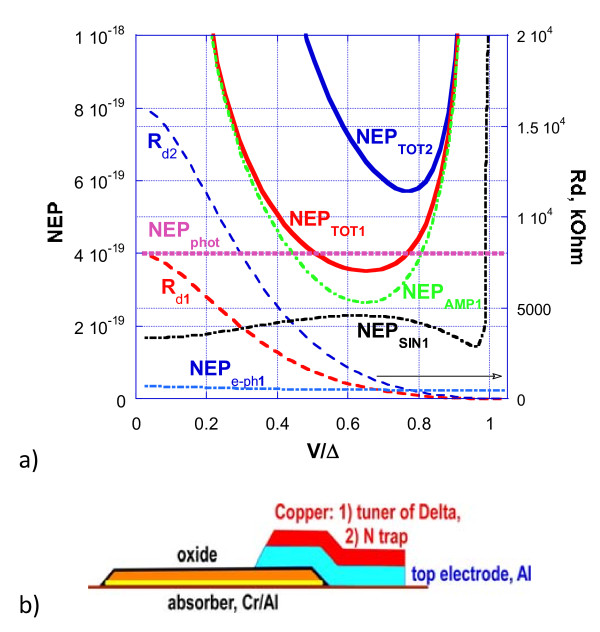
 NEP components for the 2D array of CEBs with a single SIN junction and a SN Andreev contact (marked by “1”) and with a double SIN junction (marked by “2”). The array consists of four CEBs in parallel (W = 4) and eight CEBs in series (N = 8). Dynamic resistance, Rd, is shown for both cases, on the right axis. Parameters: f = 7 THz, P0 = 0.02 fW, Iamp = 5 fA Hz−1/2, Vamp = 3 nV Hz−1/2 (JFET), R = 4 kOhm, Λ = 0.002 μm3, T = 70 mK, Tc = 400 mK. b) Fabrication of the CEB with the suppressed superconducting gap of the SIN tunnel junction.